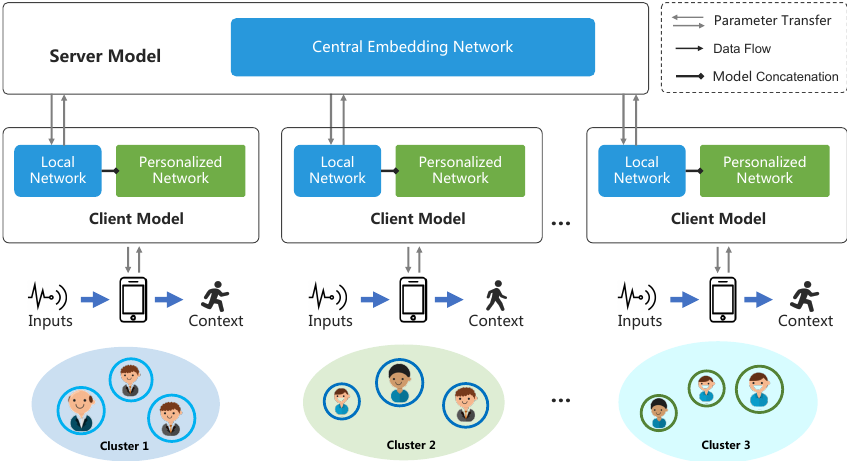
Figure 4. Overall architecture of the diversity-aware activity